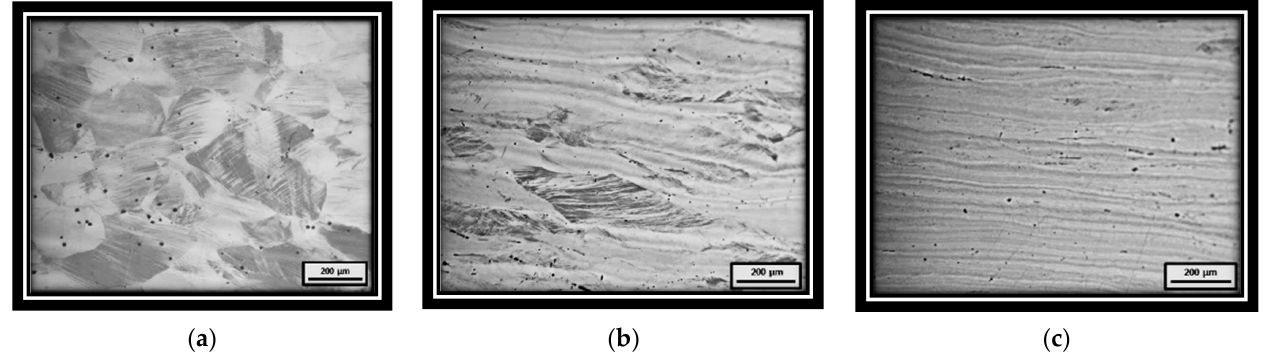
Figure 3. Microstructure of cold-deformed samples. ( a ) 40%; ( b ) 60%; ( c ) 80% reduction.